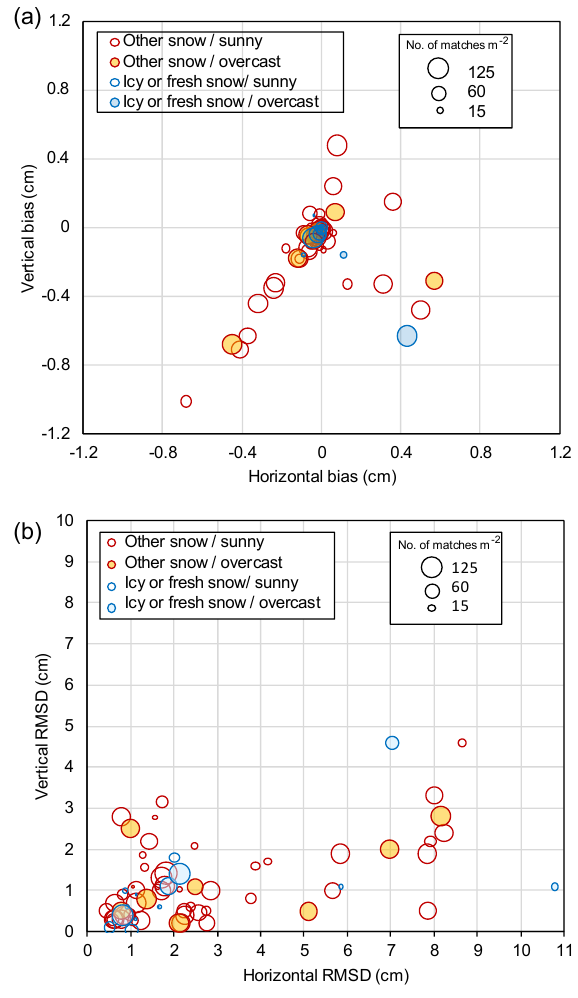
Figure 4. (a) Accuracy and (b) uncertainty of absolute geoloca- tion for digital surface models based on cross-validation with GCPs. Symbol area proportional to mission average key point match den-